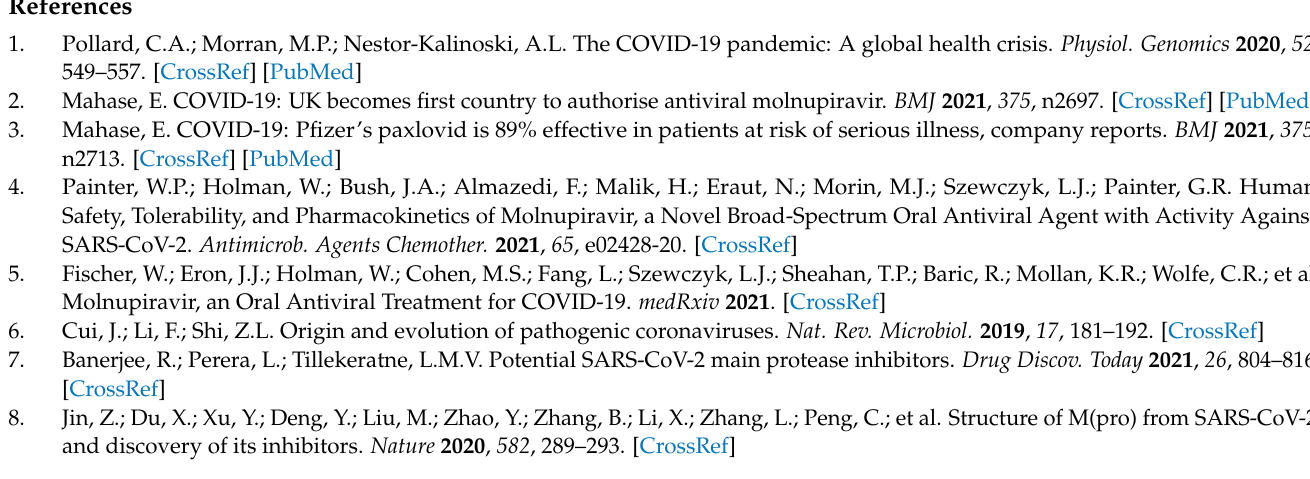
Figure S6: Monitored distances between the sulfur of the catalytic residue C145 and the electrophilic carbon of compounds 4 (panel A), 5 (panel B), 6 (panel C), and 7 (panel D) that can be susceptible to nucleophilic attack; Figure S7: RMSD calculation for each complex investigated in this study: protein (blue line) and ligand (red line); RMSF calculation for each complex, selected by docking studies, after 100 ns of MD simulation (panel A, compound 2 ; panel B, compound 3 (N3)); Figure S8: Compound 2 (panel A) and compound 3 (N3) (panel B) monitored during the simulation; Figure S9: Monitored distances between the sulfur of the catalytic residue C145 and the electrophilic carbon of compound 2 (panel A) and compound 3 (N3) (panel B) that can be susceptible to nucleophilic attack; Figure S10: Output regarding the covalent docking investigation considering compound 2 (panel A) and compound 3 (N3) (panel